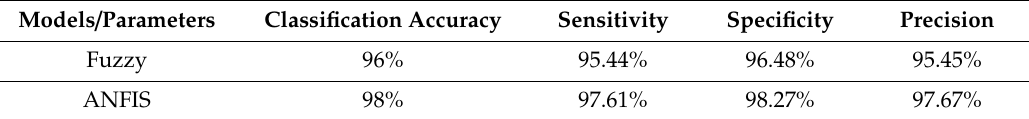
Table 26. Calculated parameters from the developed